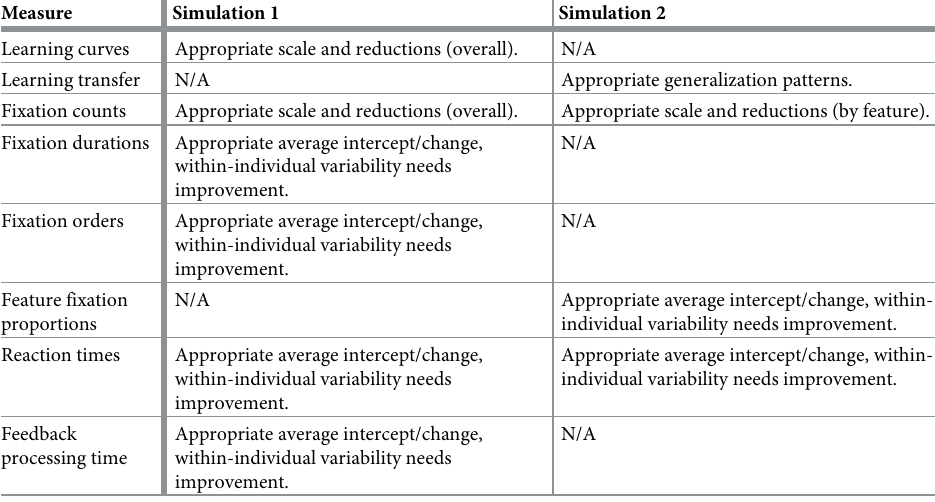
Table 4. Summary of simulation